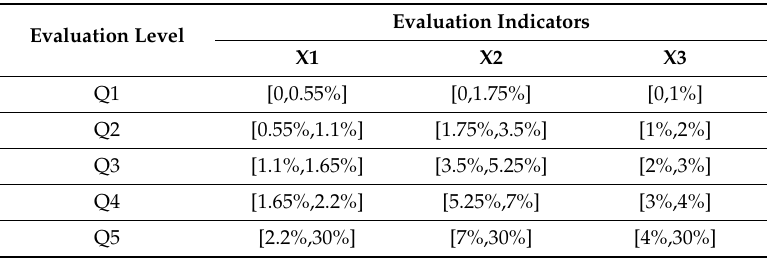
Table A1. Classification of power quality